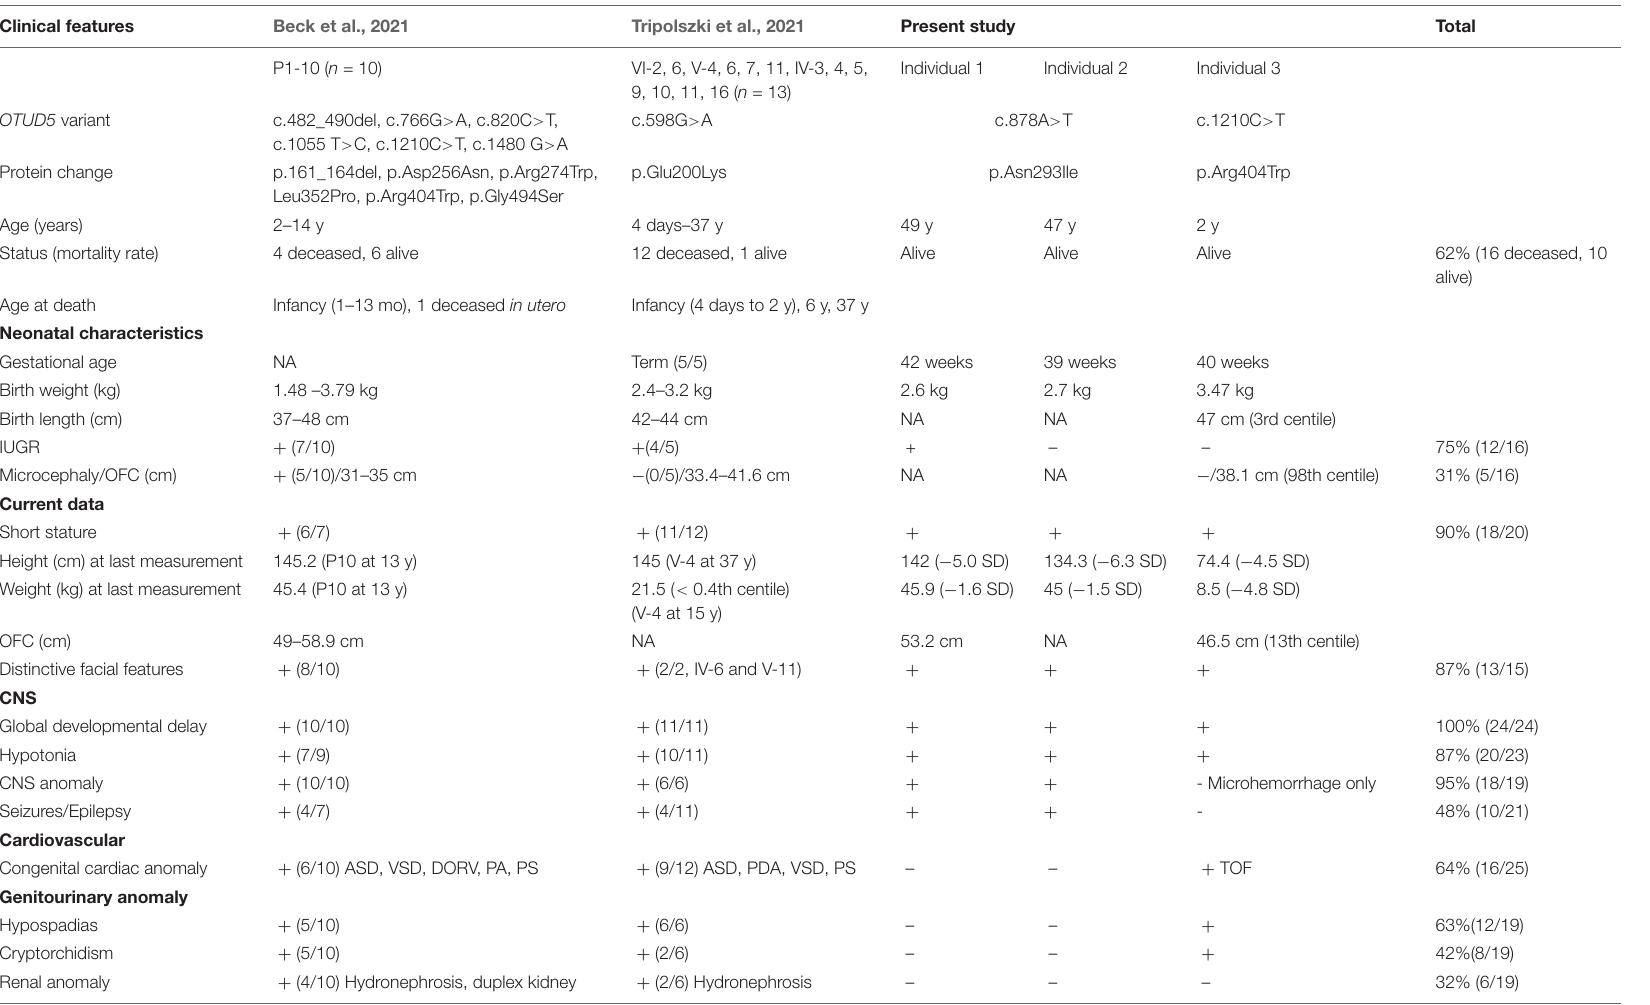
TABLE 2 | Clinical features of current and reported patients with LINKED syndrome. Clinical